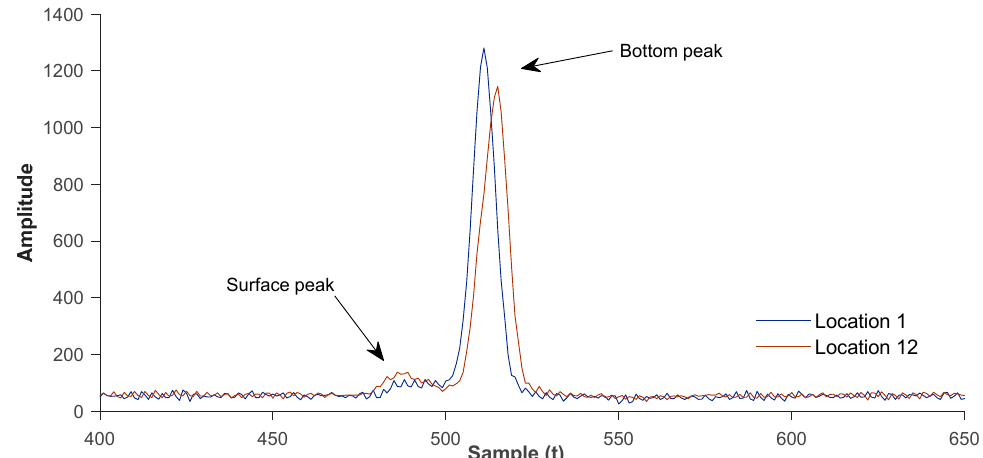
Figure 15. Averaged waveforms at sampling locations 1 and 12. Surface peak is weak, and bottom backscatter is strong, indicating shallow and transparent water columns.